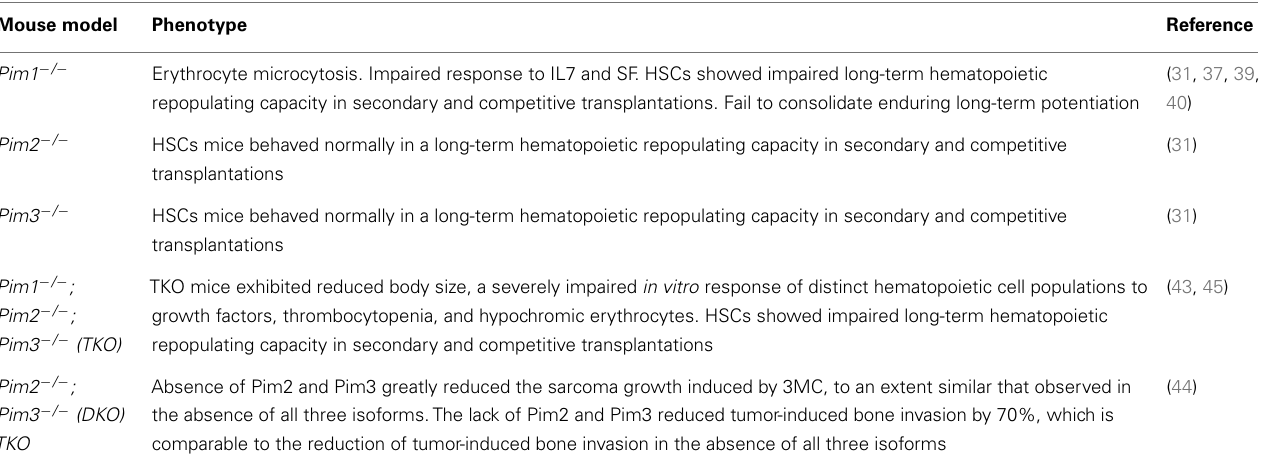
Table 3 | Mouse models with deletions of the Pim proteins